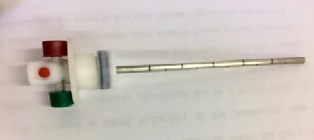
Figure 2. Sampling ports located on the 13 lateral gates.